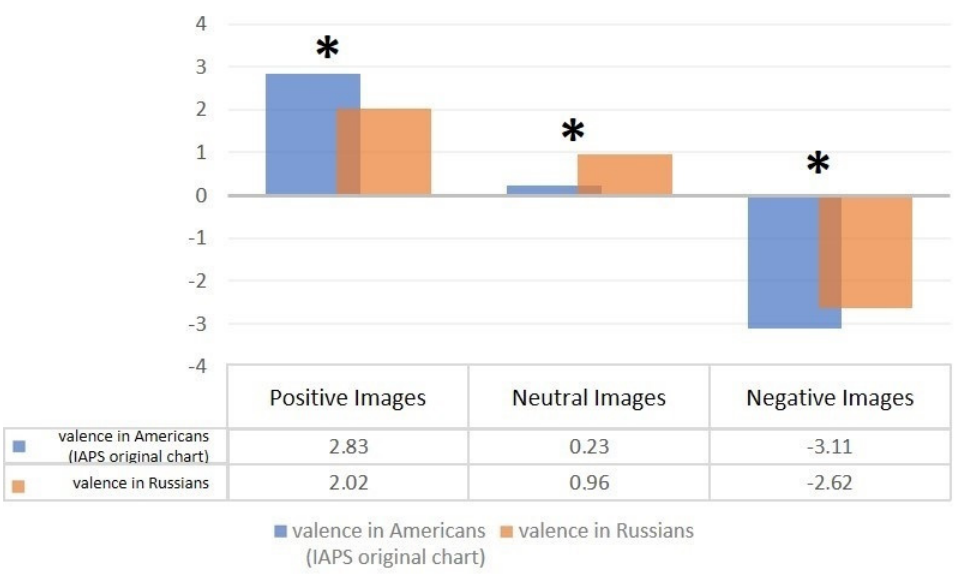
Figure 8. Comparison of the mean valence values of IAPS stimuli for each block-negative video (picBAD) and positive (picGood), negative audio (sndBad), and positive (sndGood).